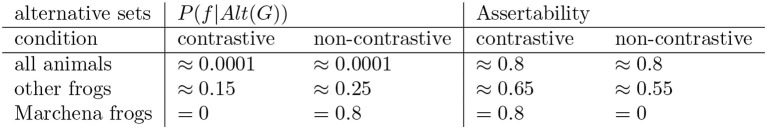
Assertability values for different alternative sets.